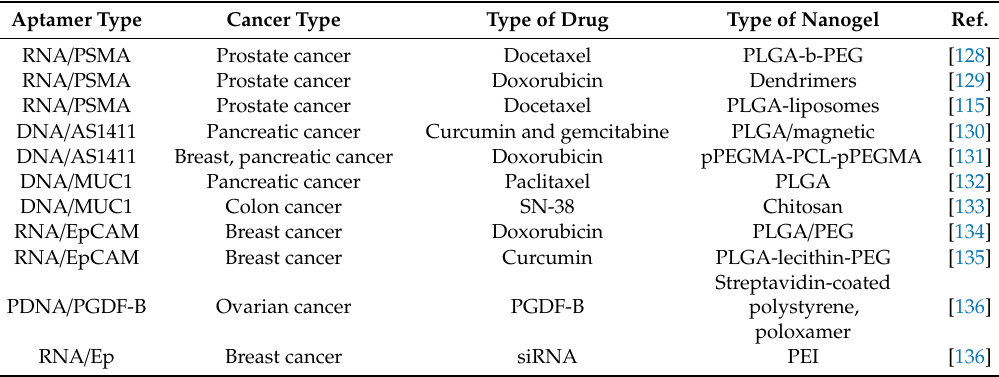
RNA—ribonucleic acid, PSMA—prostate-specific membrane antigen aptamer, AS1411—anti-nucleolin aptamer, EpCAM—epithelial cell adhesion molecule aptamer, PDNA—plasmid DNA, PGDF-B—platelet-derived growth factor B, Ep—epithelial cell, SN-38—an antineoplastic drug, the active metabolite of irinotecan drug, PLGA-b-PEG—poly(ethyleneglycol)methylether-block-poly(lactide-co-glycolide), pPEGMA-PCL-pPEGMA—poly (polyethylene glycol methacrylate)-poly(caprolactone)-poly(polyethylene glycol